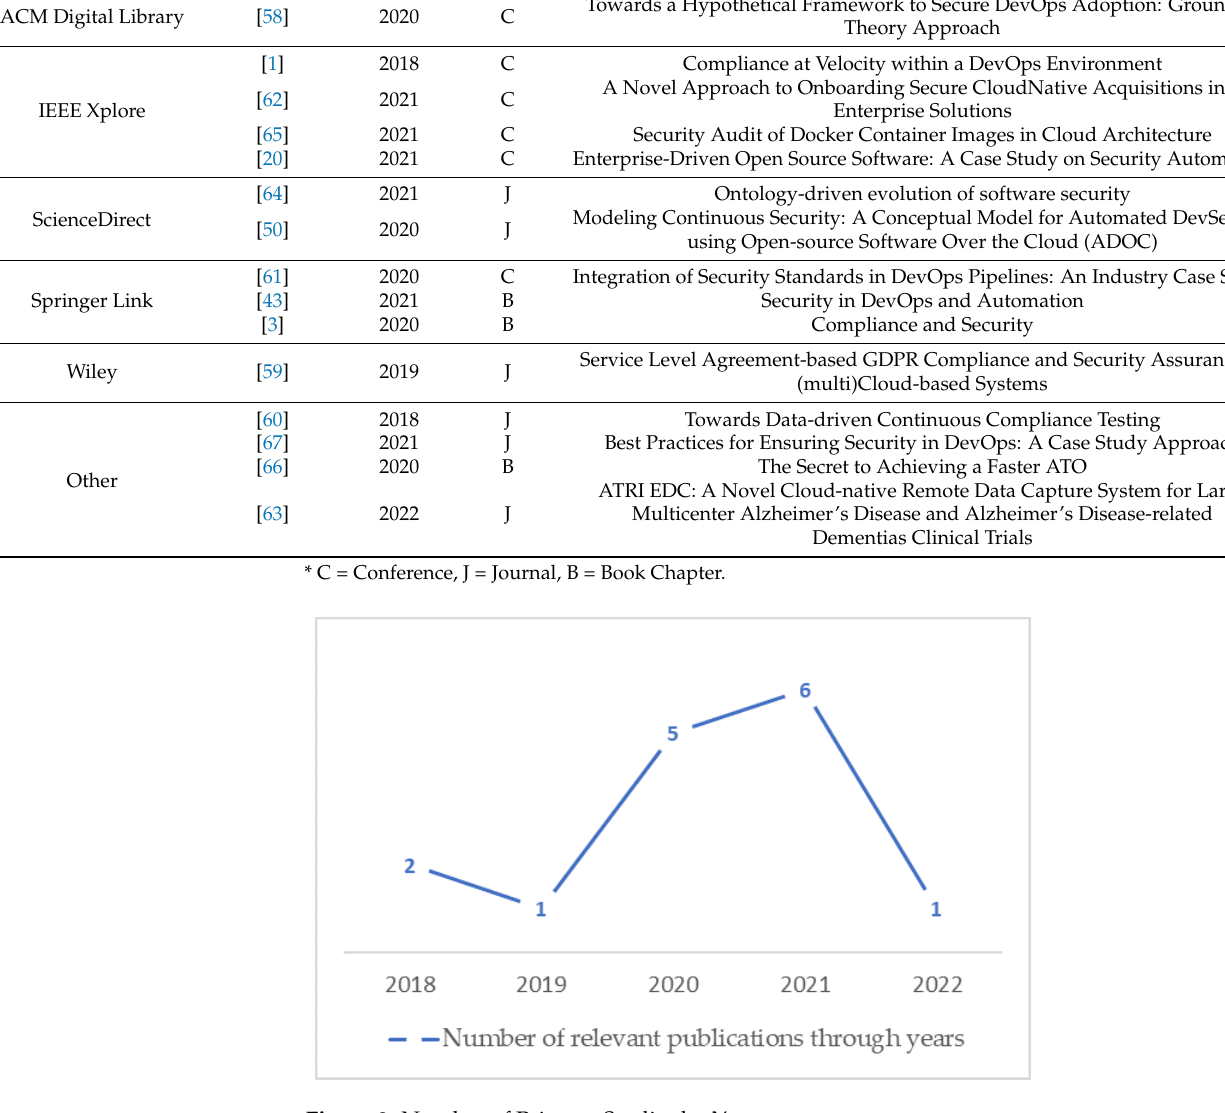
Table 4. Overview of Compliance Aspects by Year.